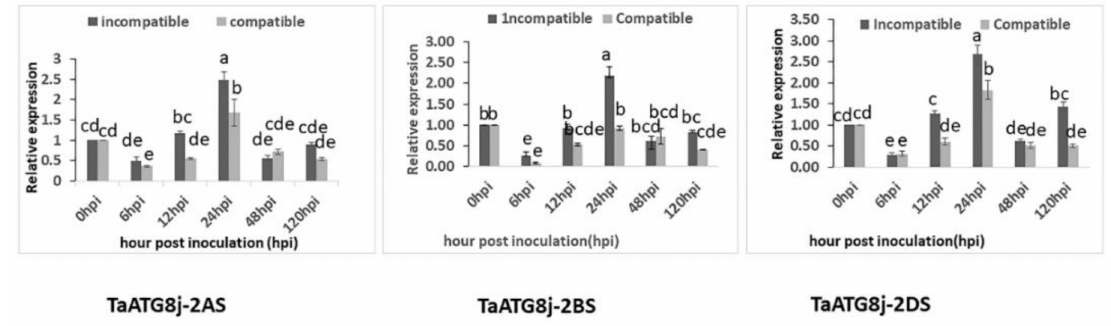
Figure 3. Relative expression levels of the three TaATG8j copies in wheat plants (cv. Suwon 11) inoculated separately with incompatible and compatible pathotypes of Puccinia striiformis f. sp. tritici . The wheat seedlings were inoculated with CYR23 (incompatible) and CYR31 (compatible) and sampled at 0, 6, 12, 24, 48 and 120 hpi. The data were standardized to the wheat elongation factor TaEF-1 α gene. The relative expression level of the gene was quantified using the comparative threshold (2 − ∆∆ C t ) method. Error bars indicate the variation among three replications, and the different letters represent significant differences ( p < 0.05) by the Tukey HSD (Honestly Significant Difference) test. hpi: hours post-inoculation.